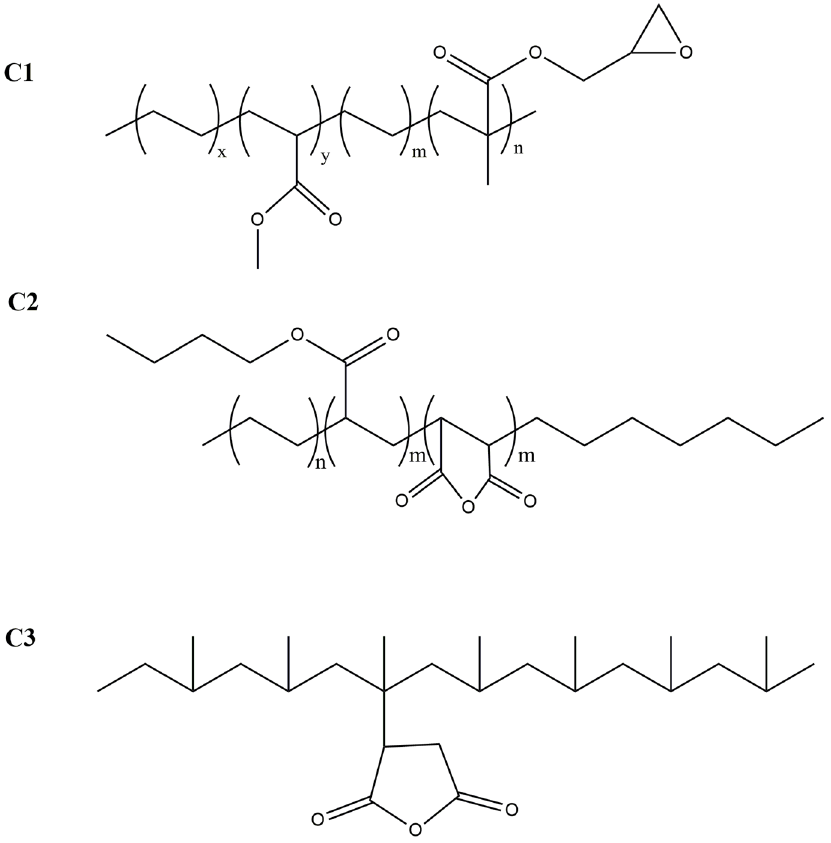
Figure 1. C1, C2 and C3 compatibilizer structures used in this work.